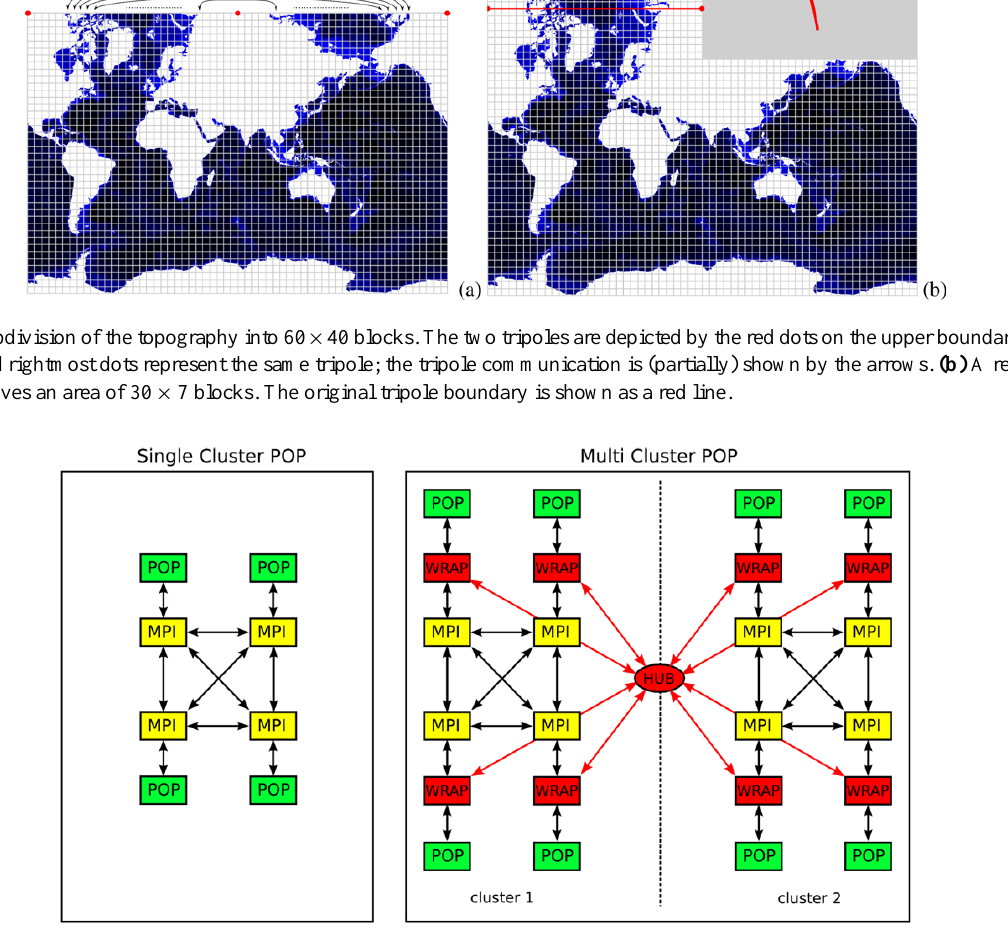
Fig. 6. An example of POP running without the MPI wrapper on a single cluster (left panel) and with the MPI wrapper on a multi-cluster (right panel).